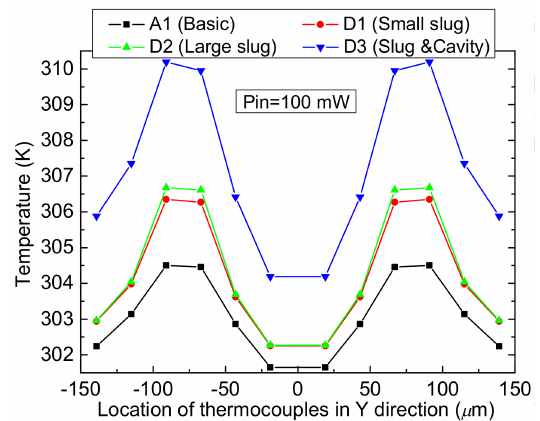
Figure 5. Temperature on hot junctions of the several thermocouples of the sensors A1, D1, D2, and D3 with respect to the location of the thermocouples in the Y direction when the power is 100